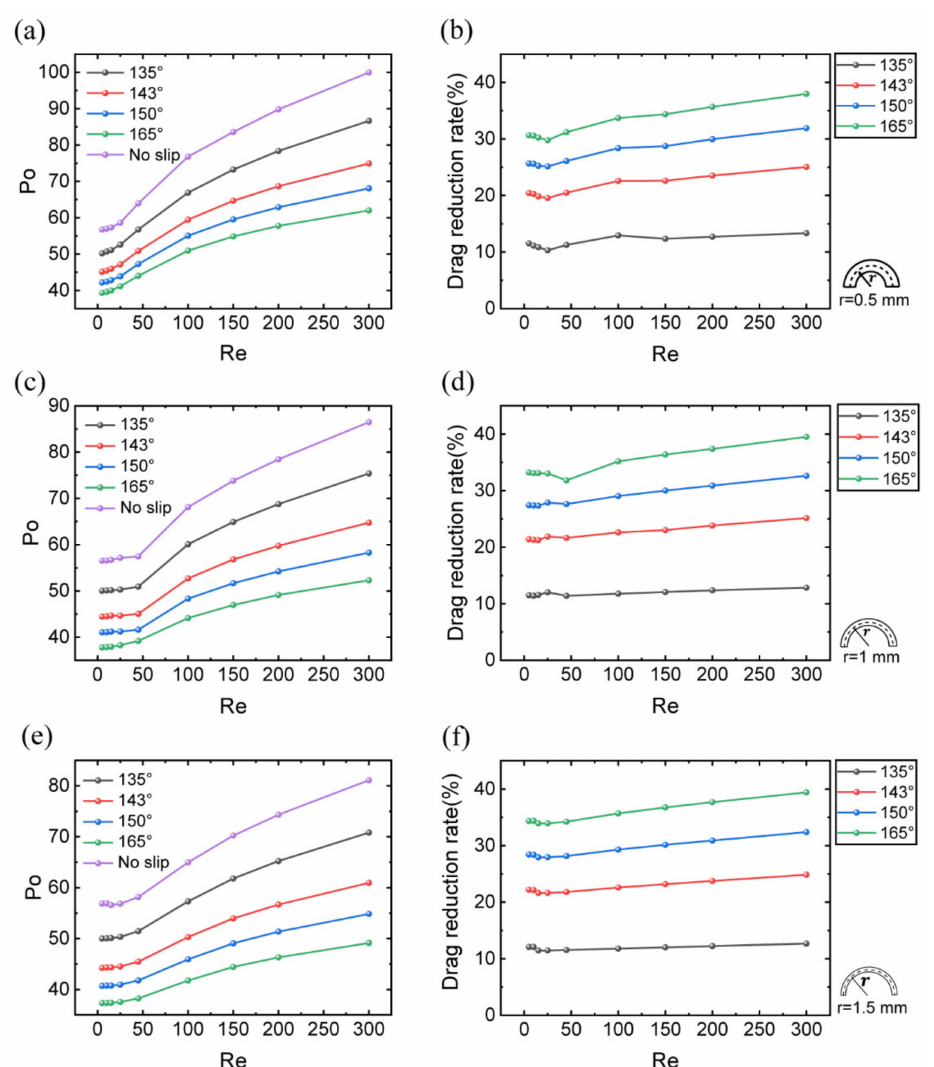
Figure 10. Po and drag reduction rate in the U-shaped microchannel: ( a , c , e ) Po as a function of Re for r = 0.5, 1, and 1.5 mm. ( b , d , f ) Drag reduction rate as a function of Re for r = 0.5, 1, and 1.5